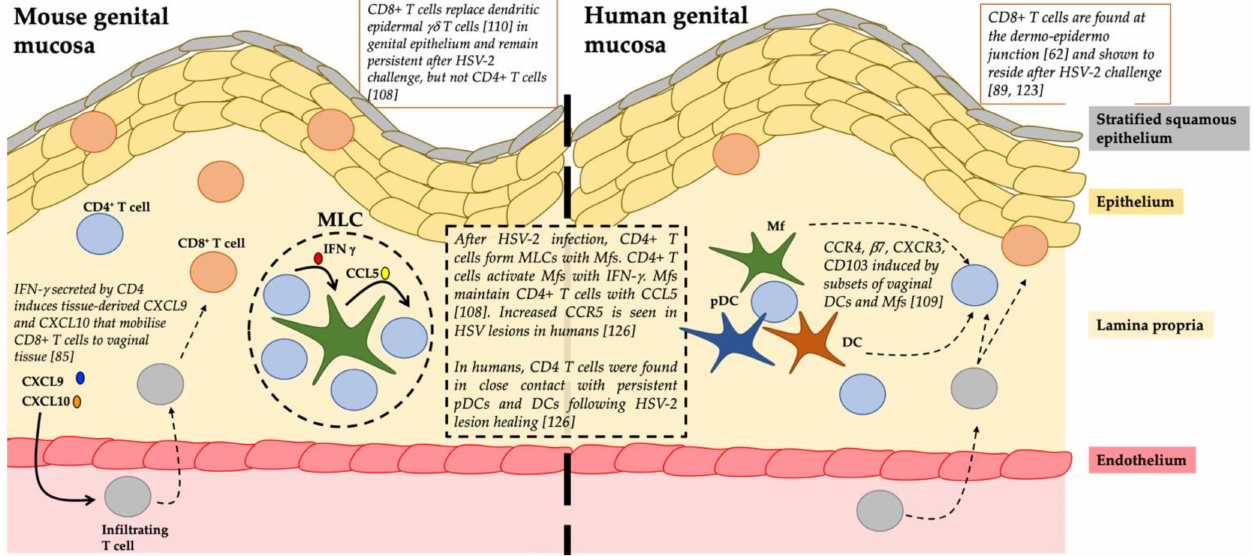
Figure 2. A summary of the role of resident memory T cells in the mouse and human genital mucosa especially during herpes simplex virus (HSV)